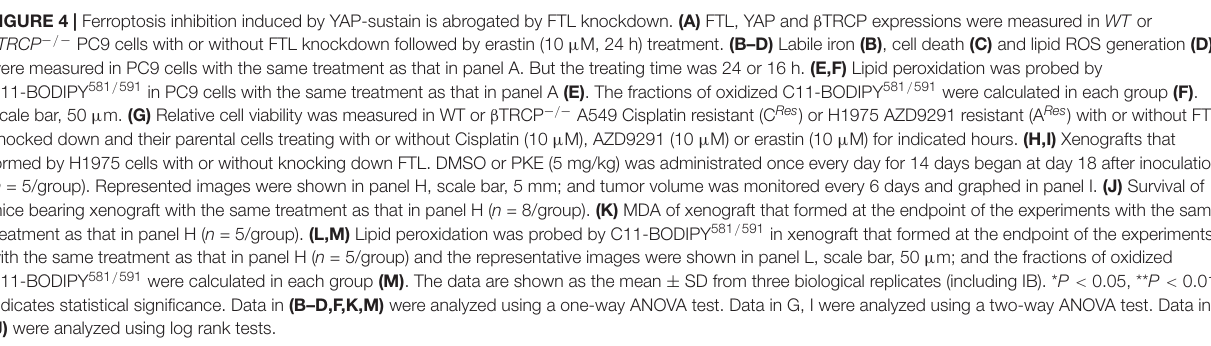
FIGURE 4 | Ferroptosis inhibition induced by YAP-sustain is abrogated by FTL knockdown. (A) FTL, YAP and β TRCP expressions were measured in WT or β TRCP − / − PC9 cells with or without FTL knockdown followed by erastin (10 µ M, 24 h) treatment. (B–D) Labile iron (B) , cell death (C) and lipid ROS generation (D) were measured in PC9 cells with the same treatment as that in panel A. But the treating time was 24 or 16 h. (E,F) Lipid peroxidation was probed by C11-BODIPY 581 / 591 in PC9 cells with the same treatment as that in panel A (E) . The fractions of oxidized C11-BODIPY 581 / 591 were calculated in each group (F) . Scale bar, 50 µ m. (G) Relative cell viability was measured in WT or β TRCP − / − A549 Cisplatin resistant (C Res ) or H1975 AZD9291 resistant (A Res ) with or without FTL knocked down and their parental cells treating with or without Cisplatin (10 µ M), AZD9291 (10 µ M) or erastin (10 µ M) for indicated hours. (H,I) Xenografts that formed by H1975 cells with or without knocking down FTL. DMSO or PKE (5 mg/kg) was administrated once every day for 14 days began at day 18 after inoculation ( n = 5/group). Represented images were shown in panel H, scale bar, 5 mm; and tumor volume was monitored every 6 days and graphed in panel I. (J) Survival of mice bearing xenograft with the same treatment as that in panel H ( n = 8/group). (K) MDA of xenograft that formed at the endpoint of the experiments with the same treatment as that in panel H ( n = 5/group). (L,M) Lipid peroxidation was probed by C11-BODIPY 581 / 591 in xenograft that formed at the endpoint of the experiments with the same treatment as that in panel H ( n = 5/group) and the representative images were shown in panel L, scale bar, 50 µ m; and the fractions of oxidized C11-BODIPY 581 / 591 were calculated in each group (M) . The data are shown as the mean ± SD from three biological replicates (including IB). * P < 0.05, ** P < 0.01 indicates statistical significance. Data in (B–D,F,K,M) were analyzed using a one-way ANOVA test. Data in G, I were analyzed using a two-way ANOVA test. Data in (J) were analyzed using log rank